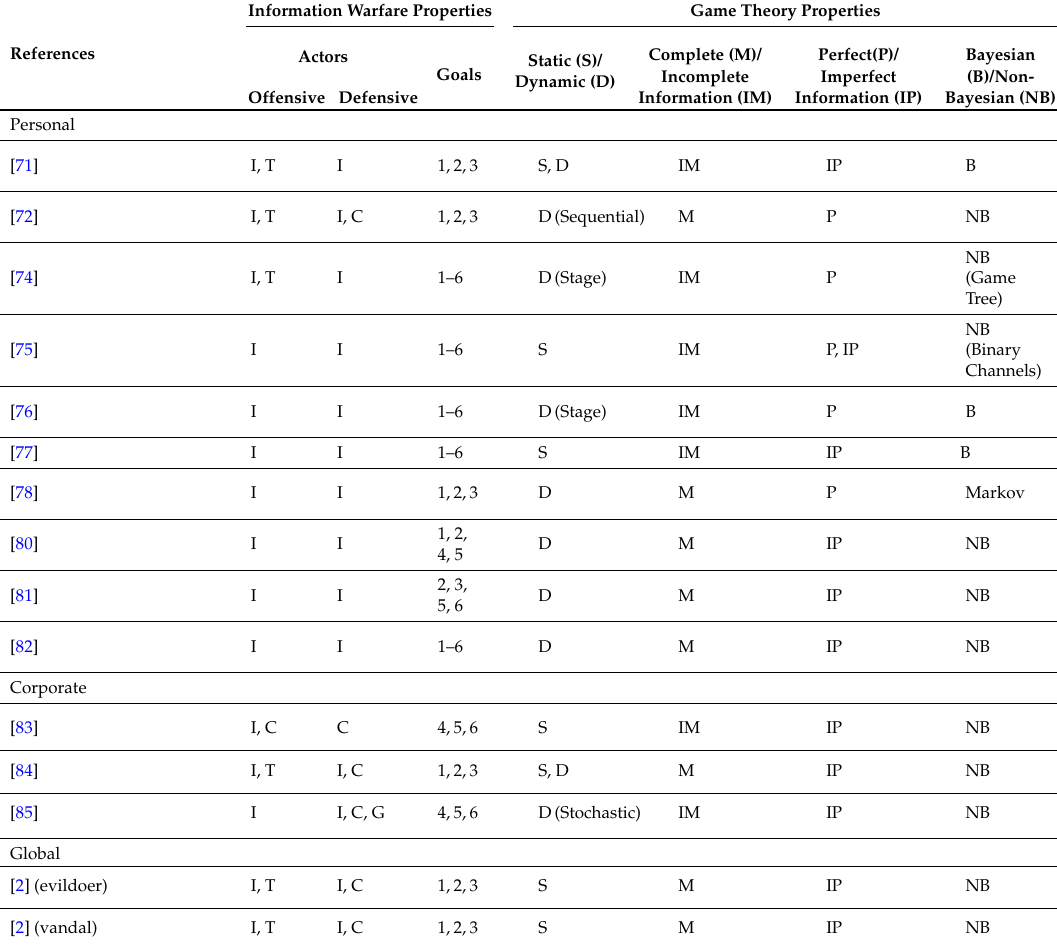
Table 8. List of Hacker Warfare